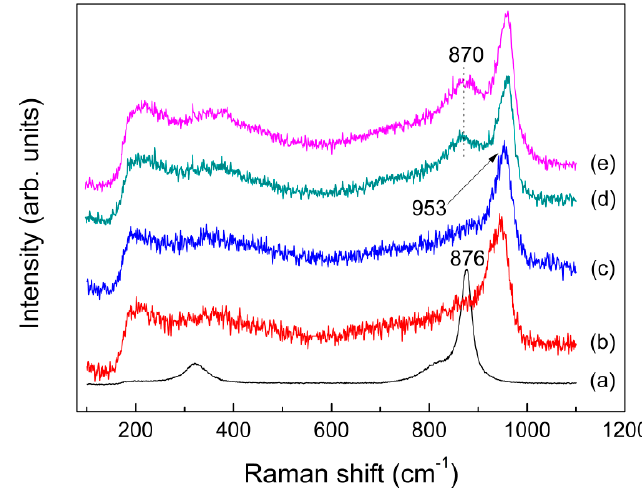
Figure 6. Raman spectra of molten: ( a ) K 2 MoO 4 at 1273 K; ( b ) K 2 Mo 4 O 13 at 1023 K; ( c ) KAl(MoO 4 ) 2 at 993 K; ( d ) fast; and ( e ) slow quenched KAl(MoO 4 ) 2 .